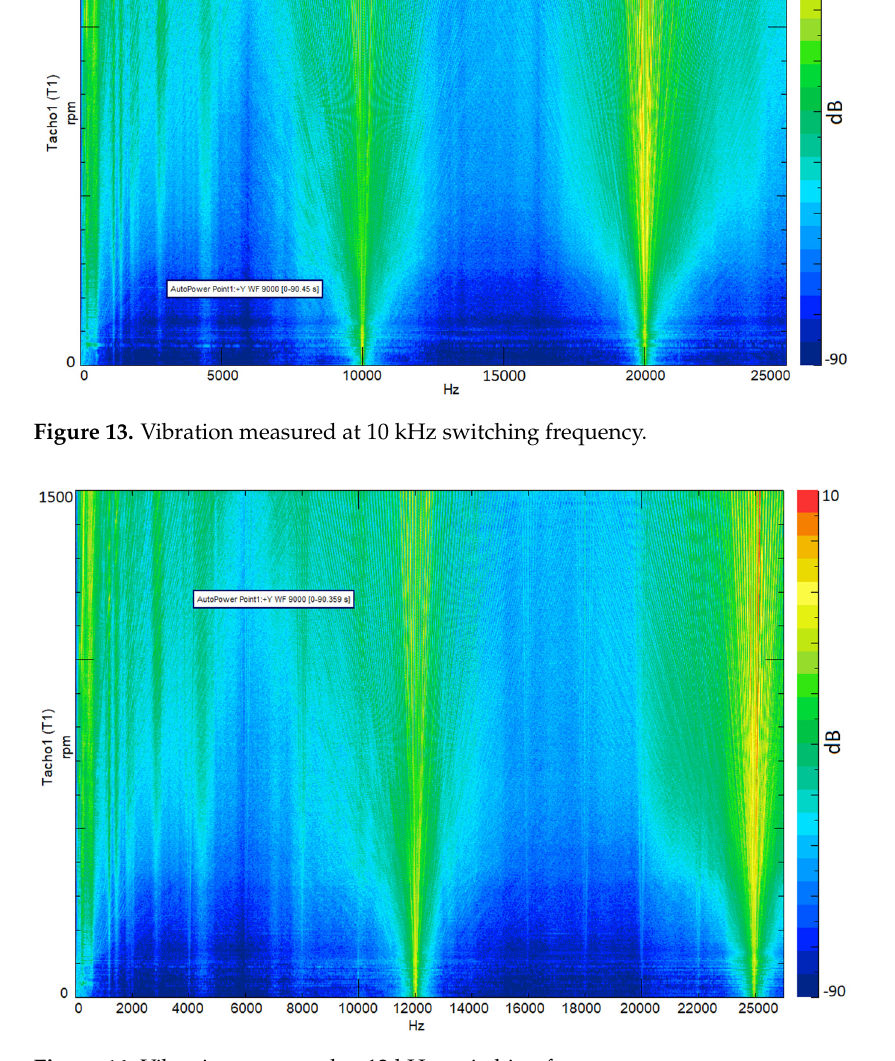
Figure 14. Vibration measured at 12 kHz switching frequency .